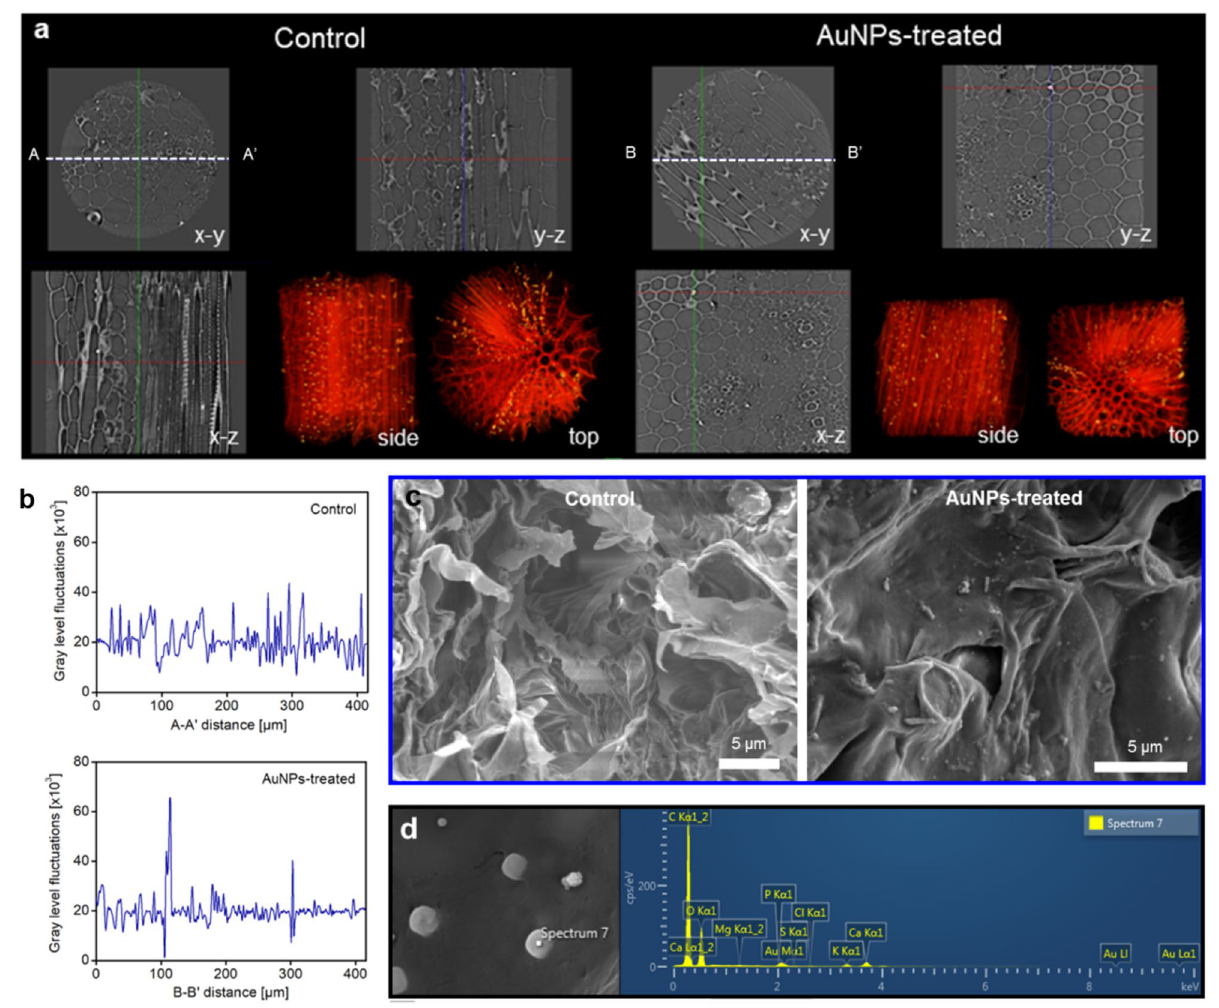
Figure 4. Visualization of AuNPs absorbed into on the surface of Perilla frutescens through stomatal pores. ( a ) 3D X-ray micro-CT images of the control (left) and AuNP-treated (right) P. frutescens . Cross-sectional images in the x–y, y–z, and x–z planes show the internal morphological structure of P. frutescens. The reconstructed 3D images show morphological structures of mesophyll cells and veins of P. frutescens . In contrast to the control P. frutescens, the AuNP-treated P. frutescens contains AuNPs in mesophyll cells, which implies the influx of AuNPs through the stomatal pathway. ( b ) Intensity variations over the A–A ′ and B–B ′ lines of ( a ). High intensity values (~ 60 × 10 3 ) in the intensity profile indicate the existence of AuNPs along the B–B ′ line for the AuNP-treated image. The A–A ′ line for the control image does not show high intensity values. ( c ) Comparison of SEM images showing the mesophyll cells of the control and AuNP-treated P. frutescens. ( d ) Element analysis of particles adsorbed to mesophyll cells by using energy-dispersive X-ray spectroscopy (EDS). The absorbed particles are inferred as AuNPs because Au peaks are